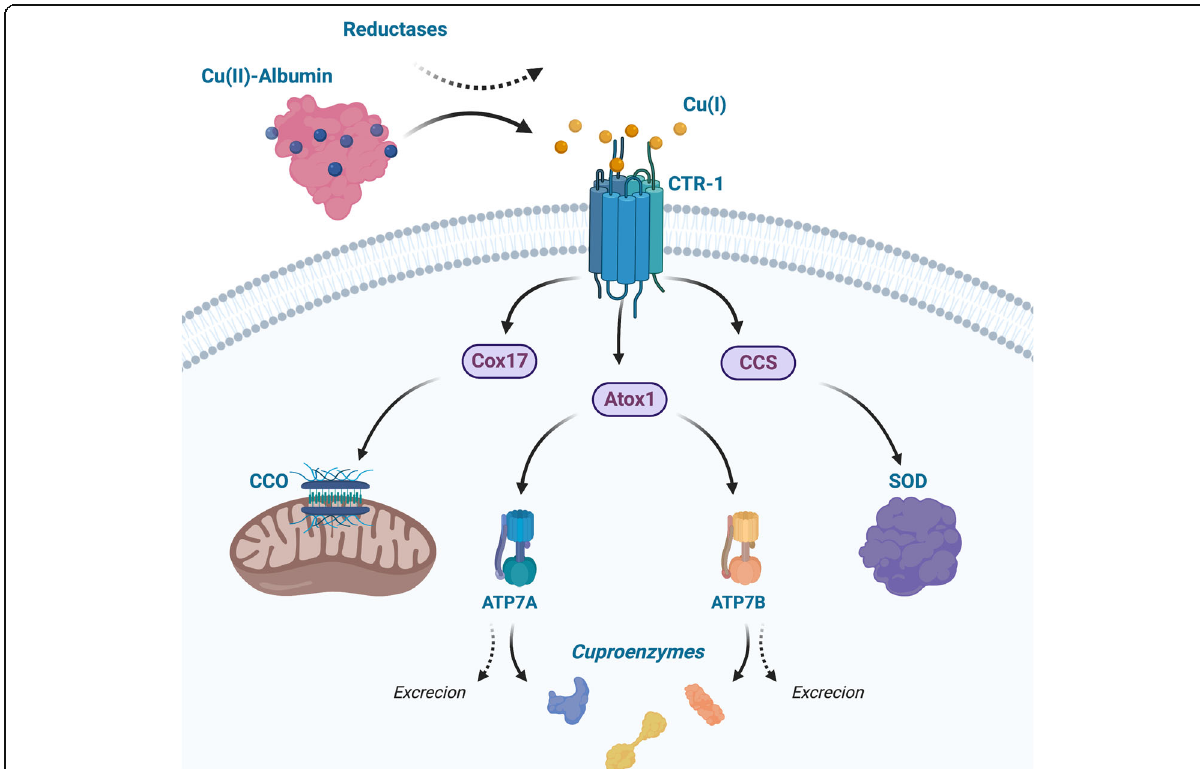
Fig. 1 Simplified illustration of copper transport mechanism. Cu(II) is carried by albumin or transcuprein in blood, and is believed to be reduced to Cu(I) by reductases near the surface of cells. Copper transporter 1 (CTR-1) is the major high-affinity copper transporter, which transports Cu(I) into the cells and deliver to the copper chaperone Cox17, the antioxidant protein 1 (Atox1), or the copper chaperone for superoxide dismutase (CCS). Atox1 further deliver copper to either the copper transporting adenosine triphosphatase (ATPase) ATP7A in neuron/astrocyte cells, or the ATPase ATP7B in the liver, which either pass the copper to target cuproenzymes, or to